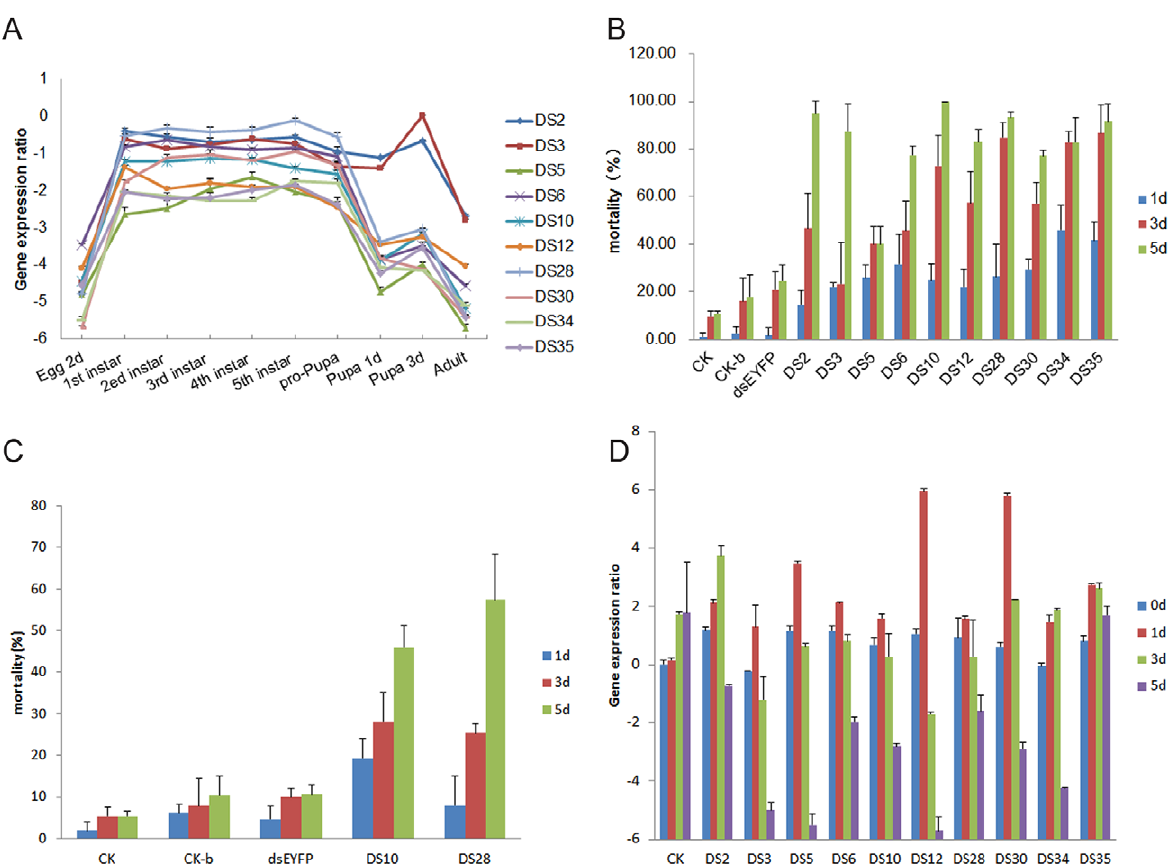
Figure 2. The relative expression level of 10 larval stage specific genes and the larval mortality. ( A ) The relative expression levels of 10 genes by qRT-PCR. All 10 genes were showing larval stage specific expression genes, and each of them was selected according to the DGE-tag copy number ( Table 5 ). The expression profile was examined from egg to adult stage in which the larval stage involved 1 st to 5 th instar larvae and pre- pupa. The results were consistent with their DGE-tag copy numbers as shown in Table 5 , indicating all of them were larval stage specific except DS2 and DS3 which had relatively higher expression level at pupal and adult stages. It was also consistent with the tag copy number ( Table 5 ). To normalize threshold cycle ( C t ) values obtained for each gene, 18S rRNA expression levels were used. ( B ) The larval mortality of dsRNA directly sprayed on the larvae along with artificial diet. Ten dsRNAs, 50 ng/ m l for each ( Table 5 ) were directly sprayed on the newly hatched larvae on artificial diet respectively. dsEYFP and the blank buffer were used as controls. The larval survival was monitored in a 5 d period. At day 5 the corrected mortality reached to more than 70% except DS5. (The data were also shown in Table 6 ). ( C ) The larval mortality of dsRNA directly sprayed on the larvae which were placed on filter paper. 50 ng/ m l dsRNA of DS10 and DS28 were directly sprayed on the newly hatched larvae on a filter paper pre-soaked in the buffer, and then the larvae were transferred to artificial diet. The blank buffer and dsEYFP were used as controls. The larval survival was monitored in a 5 d period. ( D ) The 10 gene expression levels at different time after dsRNA treatment. The expression level of 10 genes increased at 1 d after dsRNA spraying (the red bars). 8 out of the 10 genes began to decrease at 3 d after treatment except DS2 and DS34 (the green bars). However, the expression levels of all 10 genes decreased in different degree 5 d after treatment (the purple